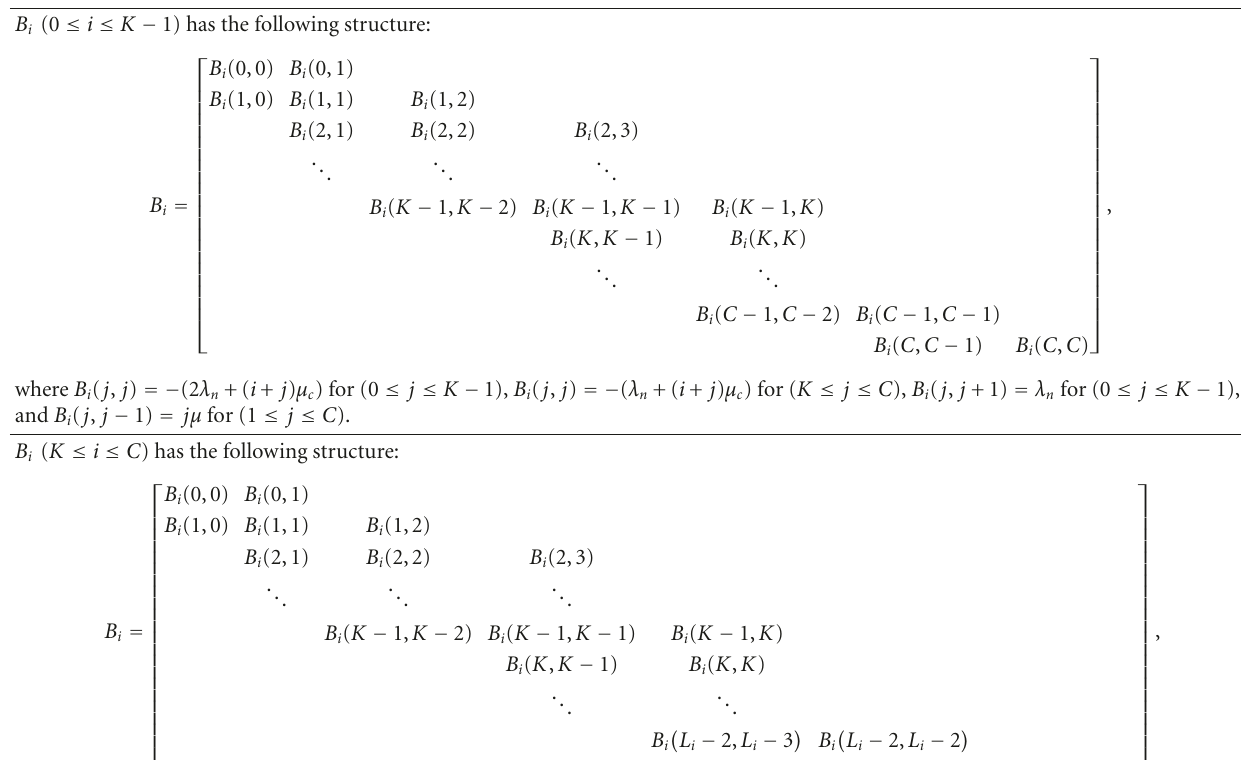
Table 1: Structure of B i in cuto ff priority guard-channel hando ff scheme for two-cell